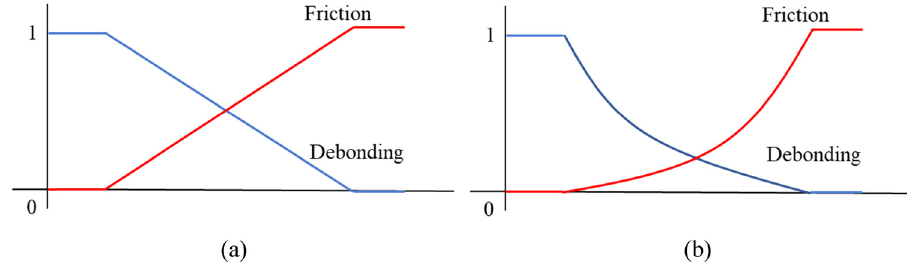
Figure 13: Combination of debonding and friction. ( a ) Linear softening model and ( b ) exponential softening model.